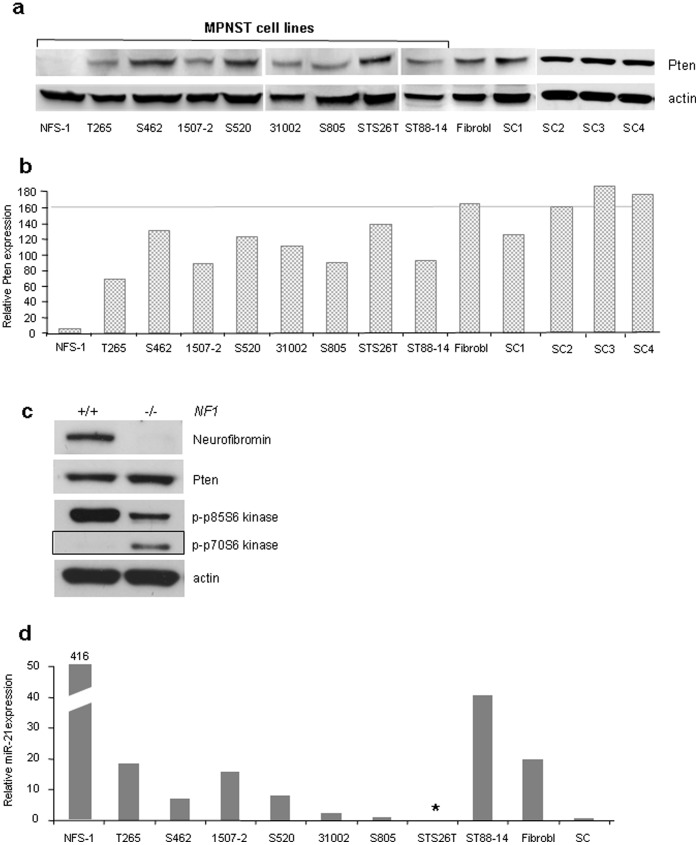
Western blot analysis of Pten and p-p70S6 kinase (isoform p-p70 of the S6 kinase, indicates mTOR activation) and examination of miR-21 expression by real time PCR a) Pten analysis of MPNST cell lines, dermal fibroblasts and neurofibroma derived Schwann cell cultures (SC1-4).The grey line indicates mean Pten expression of 4 Schwann cell cultures. b) Quantification of Pten expression (normalized with β-actin). c) Expression of Pten and p-p70S6 kinase in NF1 positive (+/+) and NF1 negative (−/−) Schwann cells. d) Relative expression of miR-21 as determined by real time PCR. * Endogeneous control RNU44 was not detectable. This cell line was thus omitted from analysis. SC = neurofibroma derived Schwann cells.